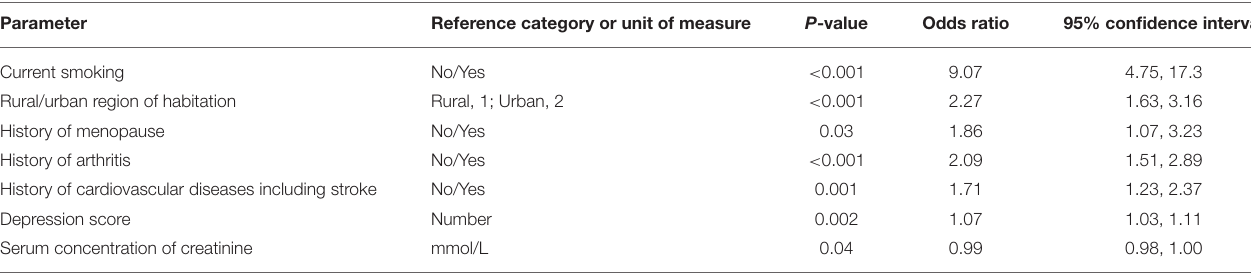
TABLE 5 | Associations (multivariate analysis) of the prevalence of airflow obstruction in women in the Ural Eye and Medical Study, with the prevalence of airflow obstruction as the dependent variable and all other listed parameters as independent variable. Parameter